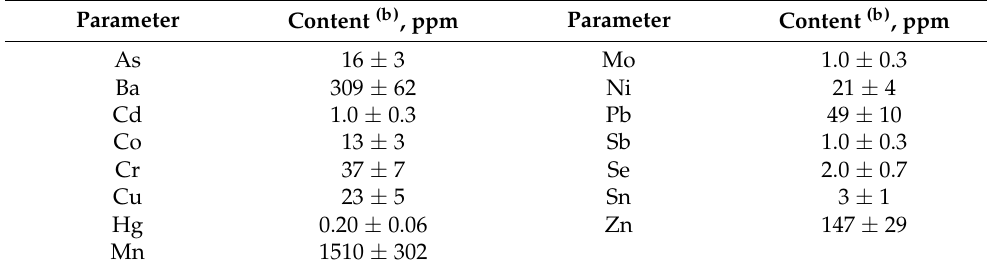
Table 7. Content of metals in the anthropogenic land soil water extract (a) (sample SW). Parameter Content (b) , ppm